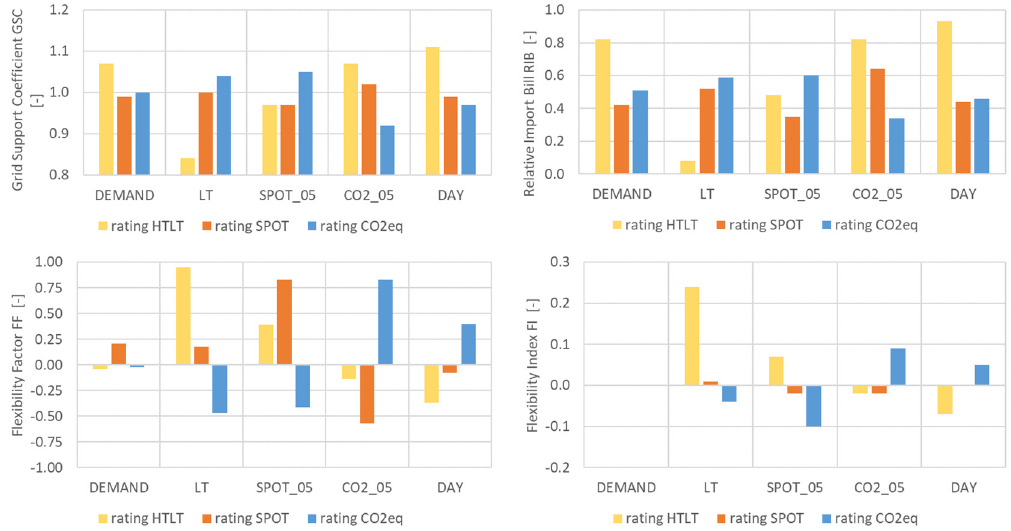
Figure 6. Flexibility factors GSC ( top left ), RIB ( top right ), FF ( bottom left ), FI ( bottom right ) depending on penalty signals [44].